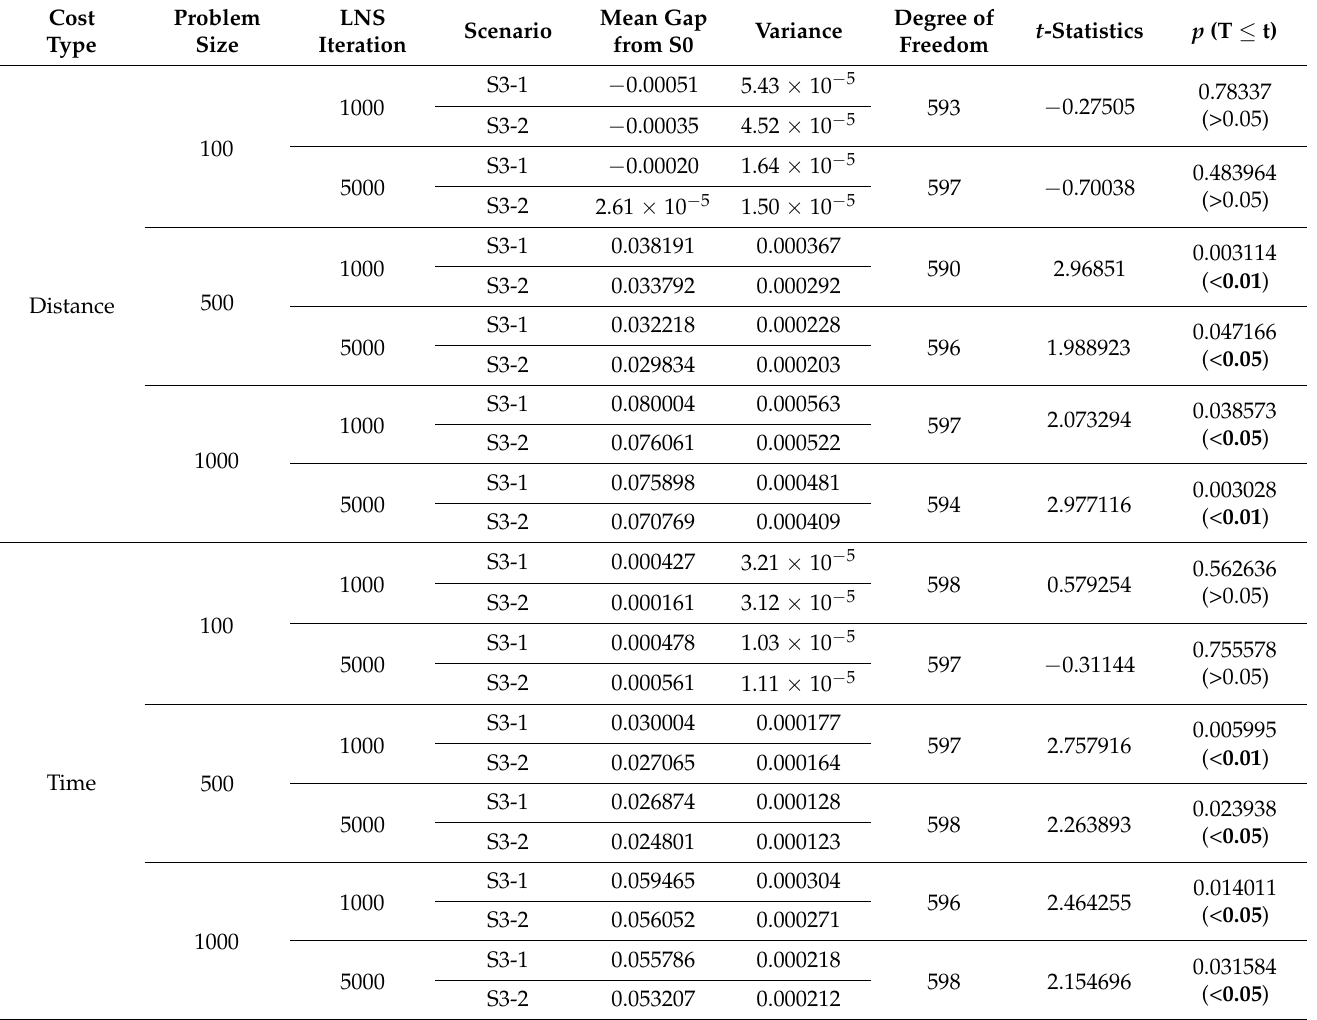
Table 4. t -test to compare the implementation scenario ‘S3-1’ and